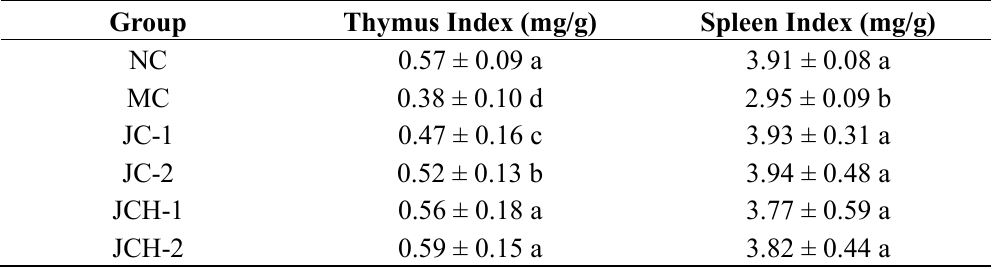
Table 2. Effects of JC and JCH on thymus index and spleen index on photoaging mice ( n =